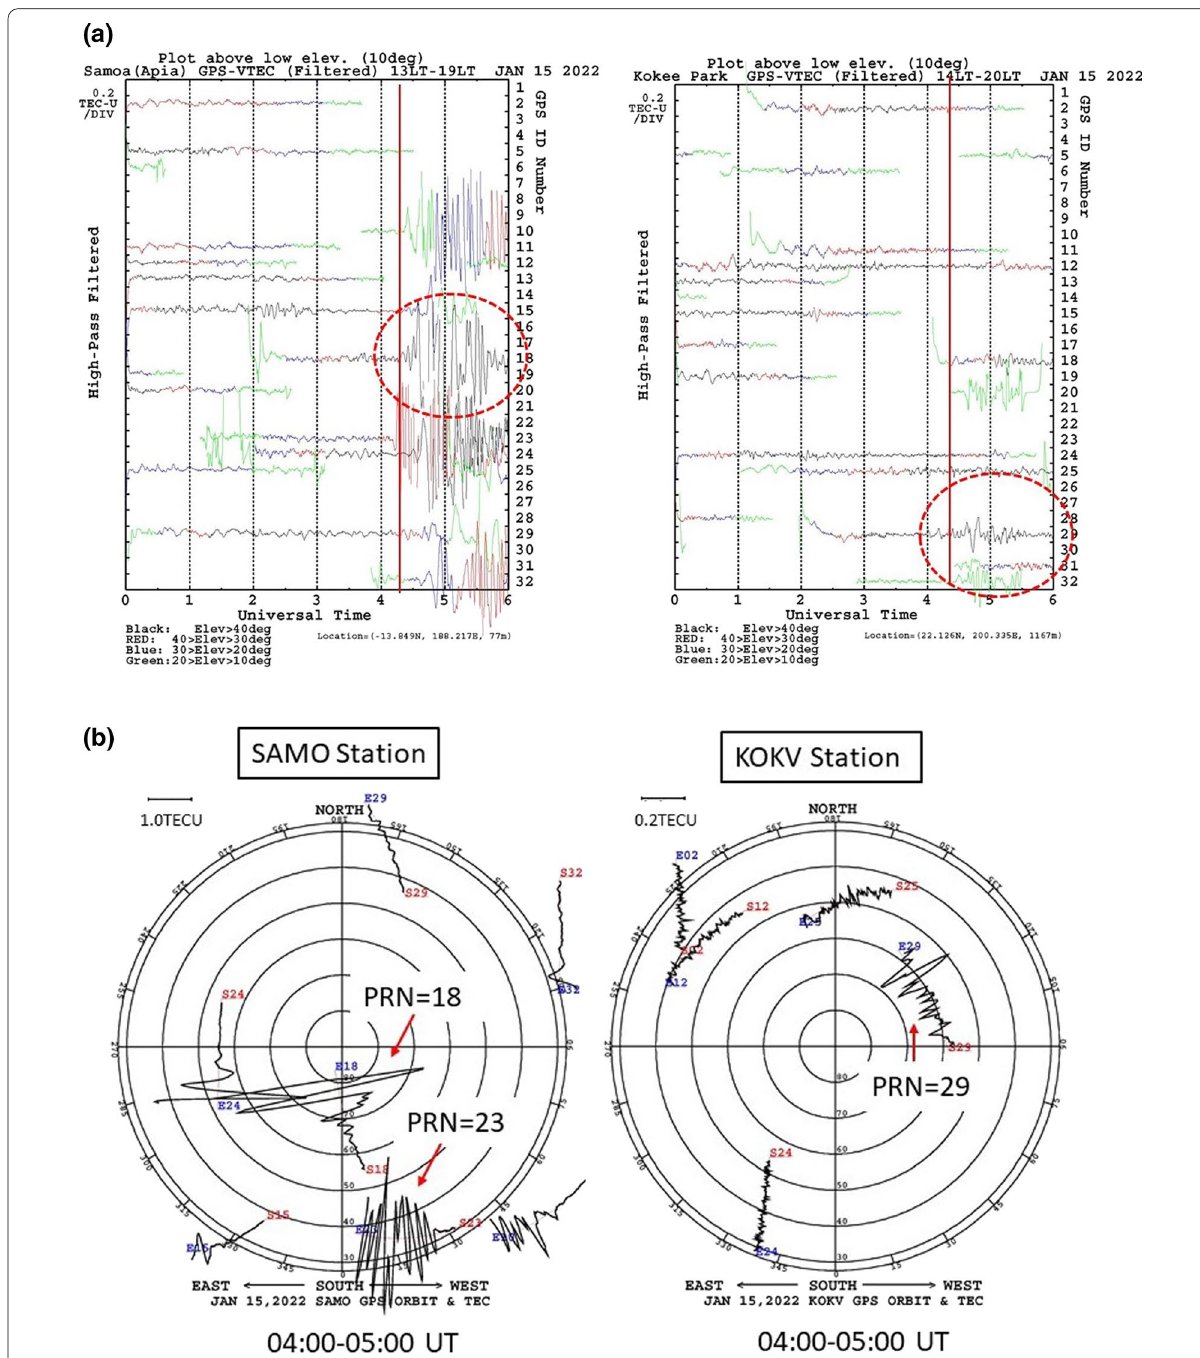
Fig. 4 a High-pass filtered GPS-TEC data observed at Samoa (SAMO, left panel) and Kokee Park, Hawaii (KOKV, right panel). At both stations, fluctuations start at around 04:15–04:20 UT about 1–6 min after the start of volcanic eruption. The different color of the lines indicates different elevation angle of the satellites as indicated under the panels. b The TEC variations along the directions of satellites seen from the receiver of the GPS satellites for KOKV (right panel) and for SAMO (left). The sky above the elevation angle 30° viewed from the ground is shown. The azimuth = angle is measured westward from the south. ‘Snn’ with red font indicates the start point (04:00 UT) of the PRN nn satellite and ‘Enn’ with blue font = indicates the end point (05:00 UT). Note that the scale is different for KOKV and SAMO, i.e., the unit scale shown at the upper left corner is 0.2 TEC unit (TECU) for KOKV and 1.0 for SAMO. c The TEC observed at the MKEA station. The format of each panel is the same as that in a and